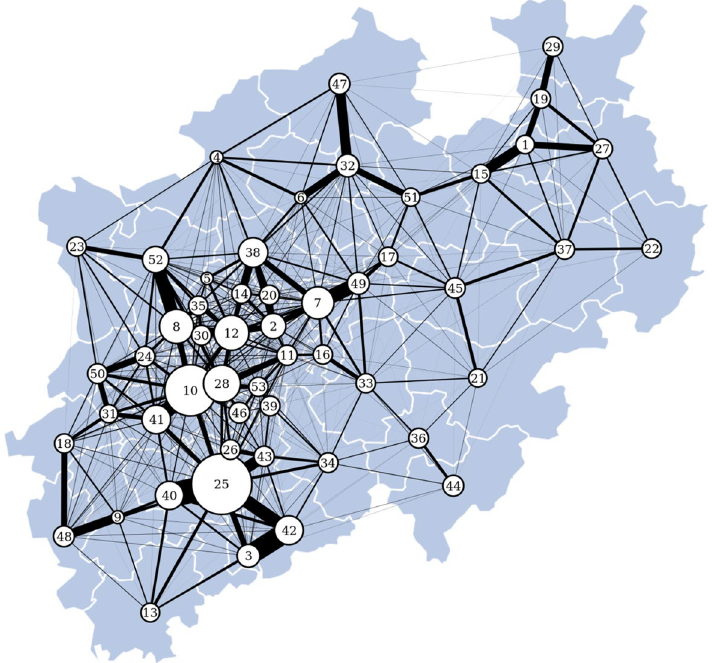
Figure 3. Commuter traffic network of North Rhine-Westphalia (NRW). Numbered vertices represent the rural and urban districts in NRW. Size of vertices represents their respective strength and thickness of edges represents the amount of commuter traffic between